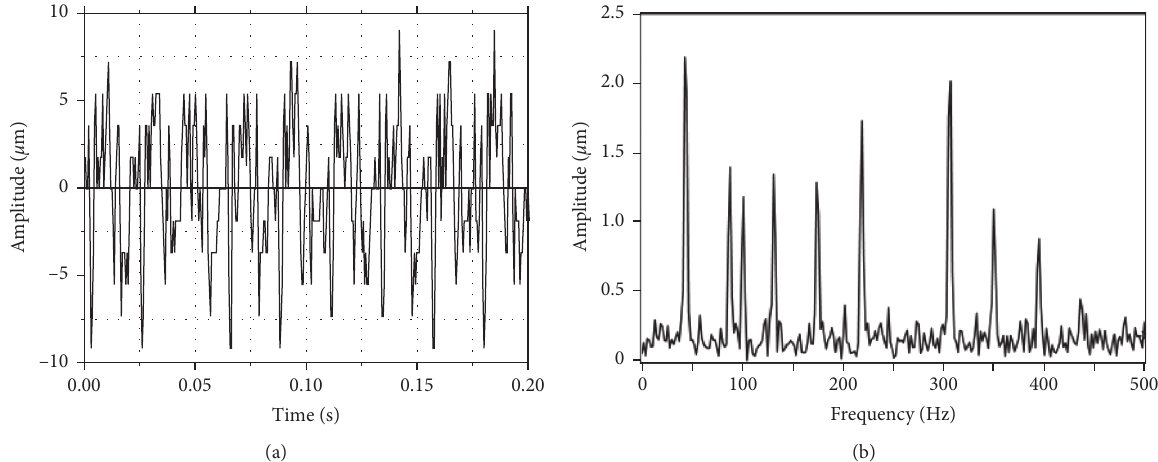
Figure 7: Vertical vibration test results of spindle front end (2600 r/min). (a) Time domain oscillogram of vertical vibration. (b) Frequency spectrogram of vertical vibration.